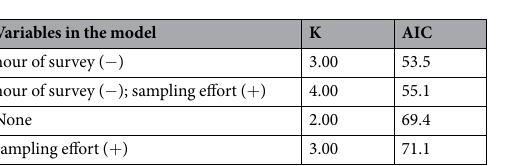
Variables in the model